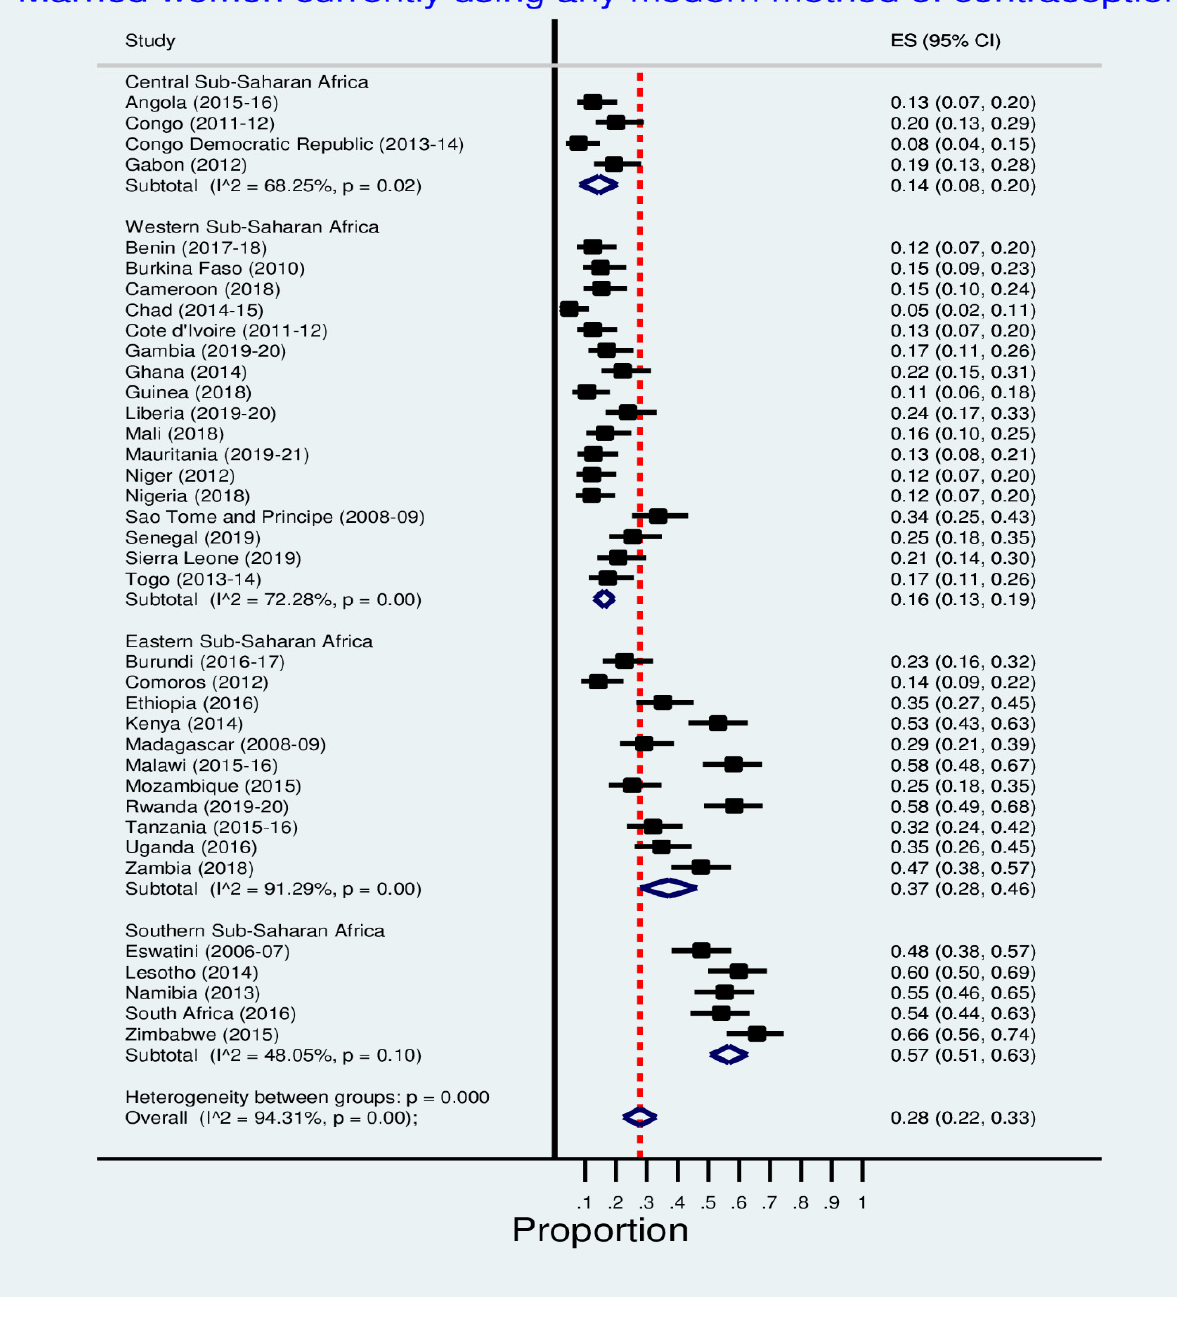
Figure 2. Prevalence of married women currently using any modern method of contraception. Table 3 shows that married women with higher socioeconomic status have a greater prevalence of using any modern method of contraception. Among urban women, those with secondary or higher education and from rich households have higher uptake of any modern method of contraceptive uptake. However, urban married women have a lower prevalence in Ghana, Liberia, Rwanda, and Sao Tome and Principe.